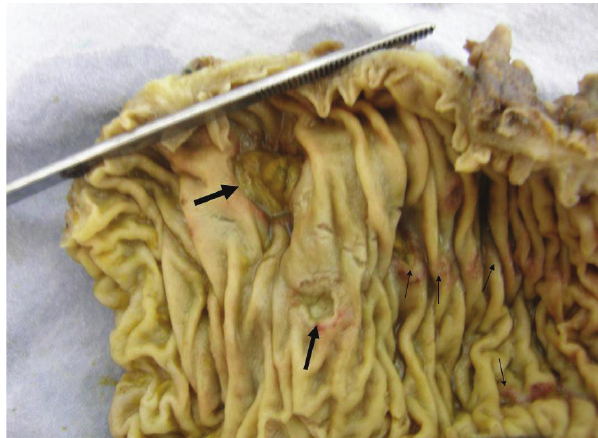
Figure 1 - Thick arrows indicate ulcers and thin arrows indicate macroscopic mucosal erosions